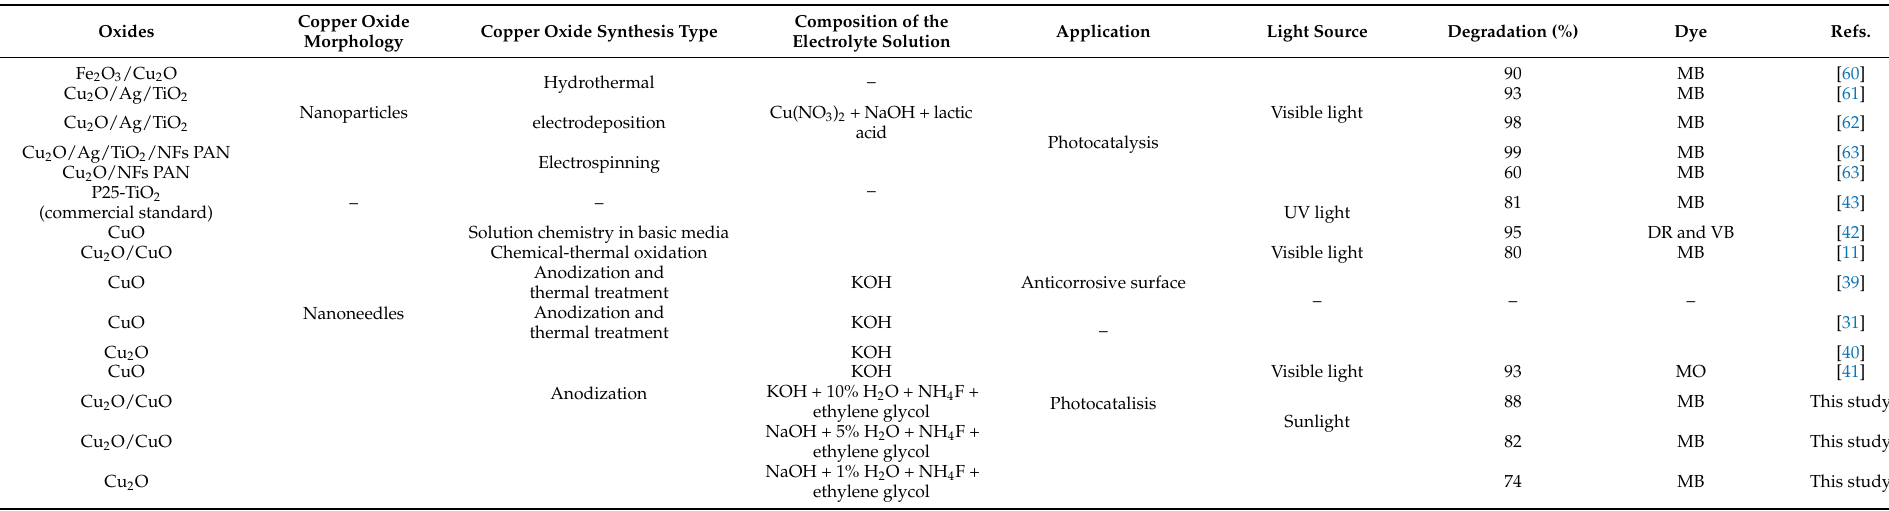
Table 2. Comparison of copper oxide nanoneedles with other metal oxide based photocatalysts previously reported in the scientific literature, their applications and their photocatalytic activity in dye